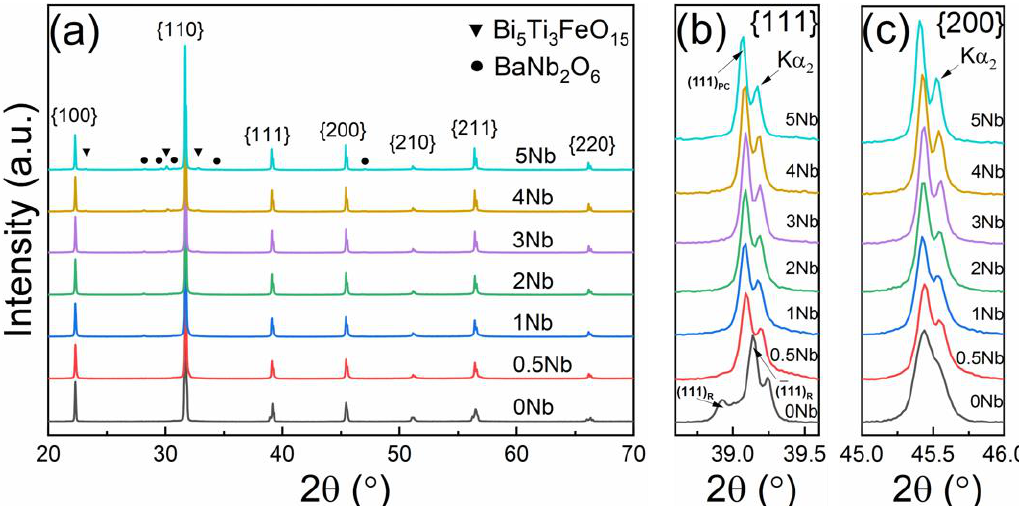
Figure 1. ( a ) Room temperature full X-ray diffraction patterns, ( b ) {111} peak profiles and ( c ) {200} peak profiles for the 0.7BF – 0.3BT – xNb ceramics (0 to 5 at% Nb). Arrow labels in ( b , c ) indicate peaks associated with Cu K α 2 x-rays. Table 1. Lattice parameters of 0.7BF – 0.3BT – xNb ceramics determined by full-pattern refinement. Numbers in parentheses indicate the uncertainty in the least significant